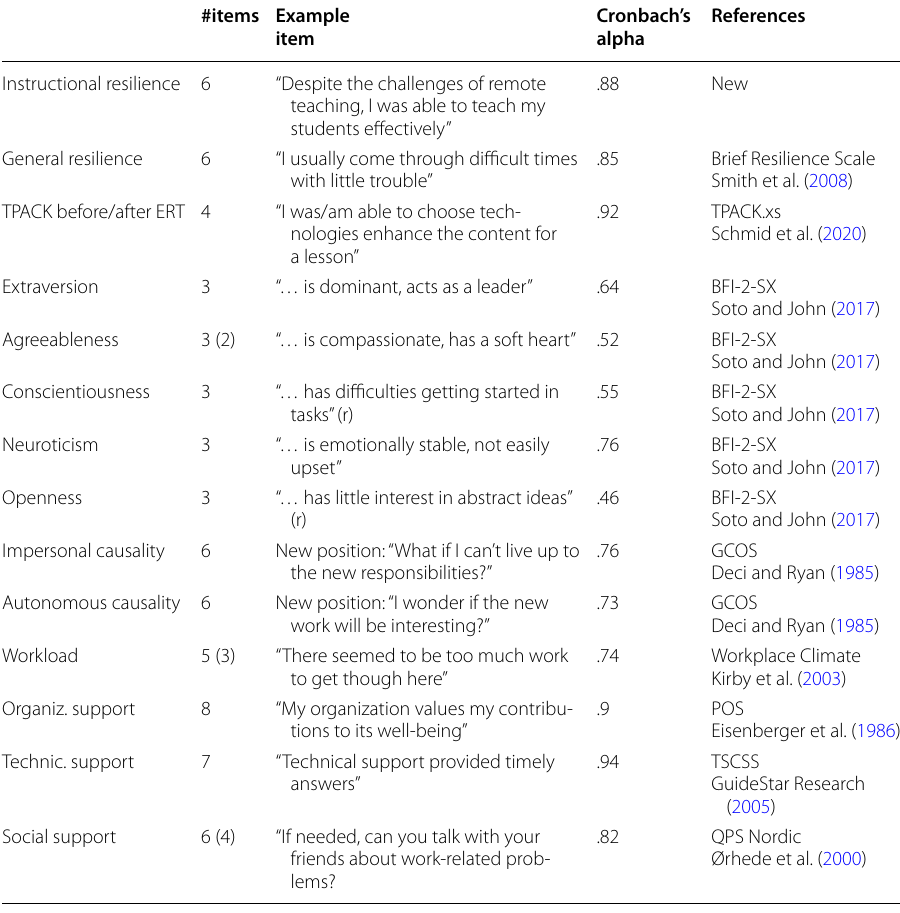
Table 1 Psychometric measures used in this study #items Example